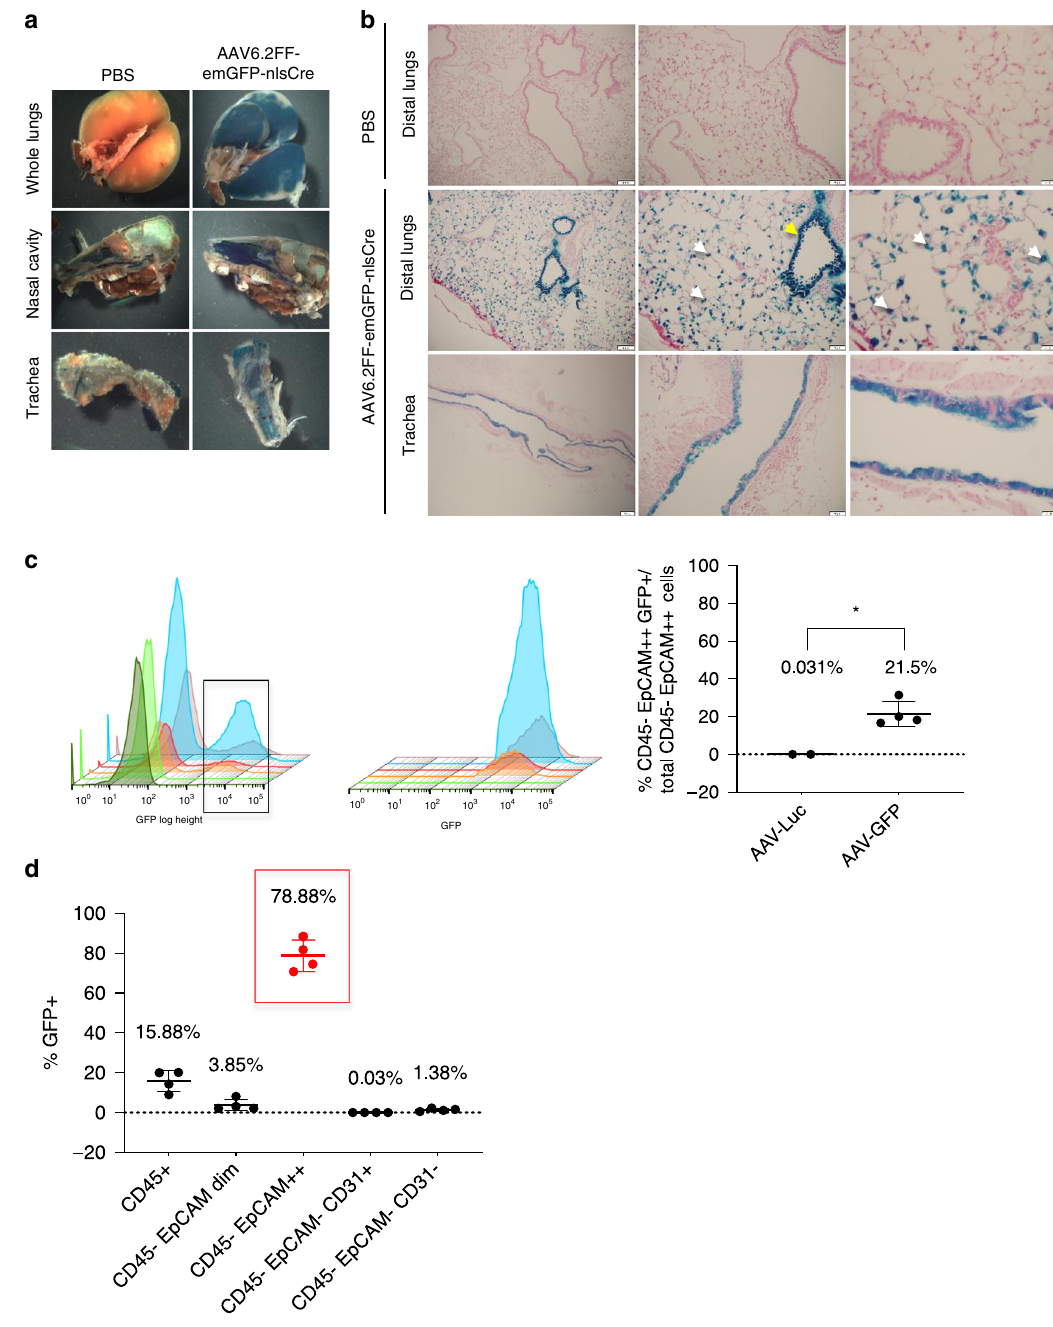
Fig. 2 AAV6.2FF transduces both airway and alveolar epithelial cells. a Whole-mount X-gal staining of the lungs, nasal cavity and trachea 3 weeks post- vector administration from either 1 × PBS or AAV6.2FF-emGFP-nlsCre treated Rosa26-Flox/LacZ mice. b Representative nuclear fast red counterstained paraf fi n sections (4 μ m) from X-gal stained lungs. LacZ-positive cells were found in the distal airway epithelium and alveoli following delivery of AAV6.2FF- CMV-emGFP-nlsCre. Morphologic criteria demonstrate that both AT2 (white arrows) and club cells (yellow arrow) are X-gal positive (Distal lung scale bars represent 100 μ m, 50 μ m, and 20 μ m from left to right; Trachea scale bars represent 200 μ m, 50 μ m, and 20 μ m from left to right). c 3D histograms from fl ow cytometry analysis of dissociated whole lungs harvested from transgenic SP-B mice 8 days after IT administration of 10 11 vg per mouse of AAV- Luc control ( n = 2), or 10 11 vg per mouse of AAV6.2FF-GFP (AAV-GFP; n = 4). The fi rst set of histograms represent the total CD45 negative, EpCAM ++ (high expressing) cell population ( fi rst peak), and the CD45 negative, EpCAM ++ cells that are GFP positive (second peak) in each mouse. The second set of histograms are the rescaled CD45 negative, EpCAM ++ , GFP positive cell populations as indicated by the black box in the fi rst histogram. The column graph represents the mean percentage of total CD45 negative, EpCAM ++ cells that are GFP positive with SD ( P value = two-tailed Student ’ s t test, * P = 0.0127). d This column graph represents the mean percentage of different lung cell populations with SD that are GFP positive. CD45 positive staining represents hematopoietic cells, CD45 negative, EpCAM dim staining represents alveolar type 1 (AT1) epithelial cells, CD45 negative, EpCAM ++ staining represents AT2 or ciliated cells (red circles and red box), CD45 negative, CD31 positive staining represents endothelial cells, and CD45 negative, EpCAM negative, CD31 negative represents all other cell types found in dissociated lung tissue ( n = 4 biologically independent animals per group). The source data for c and d have been provided as a Source Data fi